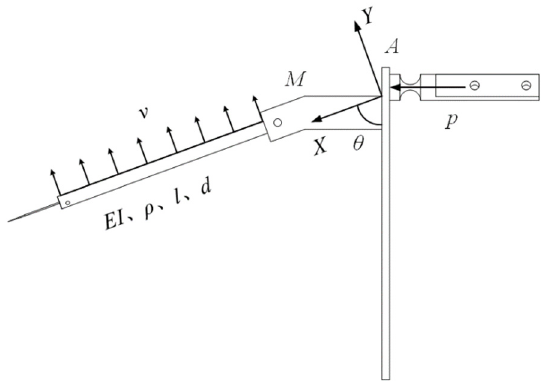
Figure 3. Mechanical model of the finger and circular plate.